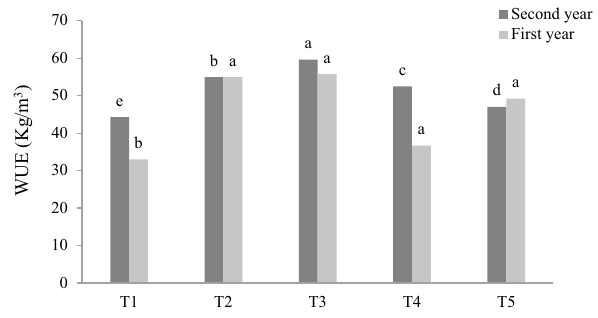
Fig. 9 Water-use efficiency (WUE) in research treatments